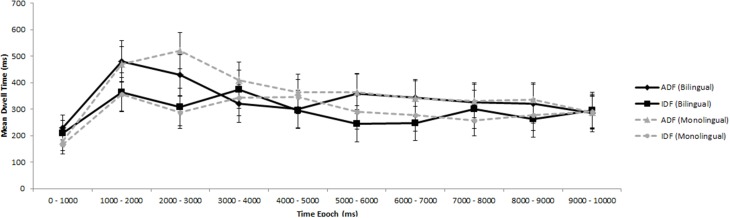
Infants' looking patterns in Experiment 1B. The solid black line represents bilingual infants' looking patterns to the adult-directed face (ADF) and the infant-directed face (IDF); the dotted gray line represents monolingual infants' looking patterns. Error bars represent the 95% confidence interval.